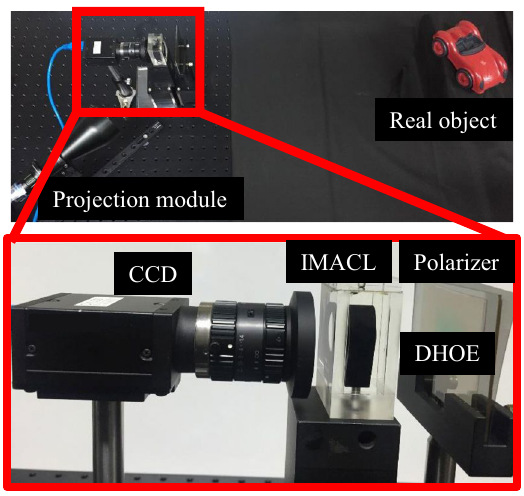
Figure 6. Experimental setup of proposed AR-HMD system using IMACL.